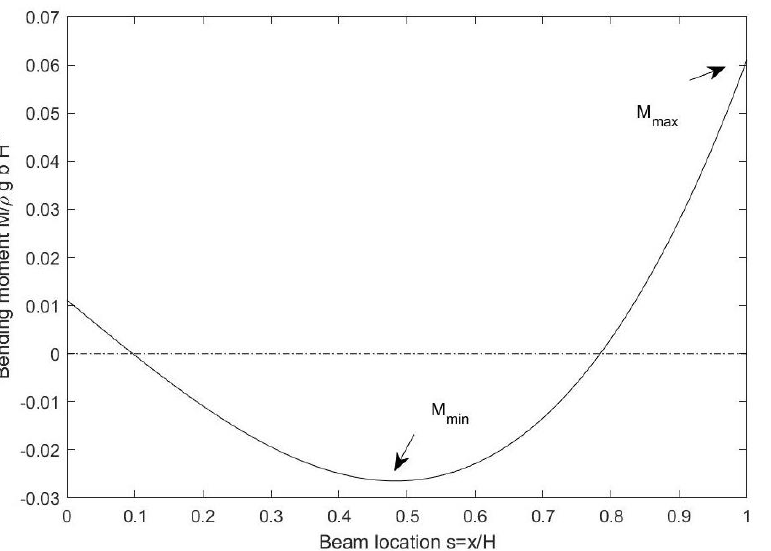
Figure 13. Bending Moment distribution over the depth of the equivalent stiffener. The dot-dash line represents the zero bending